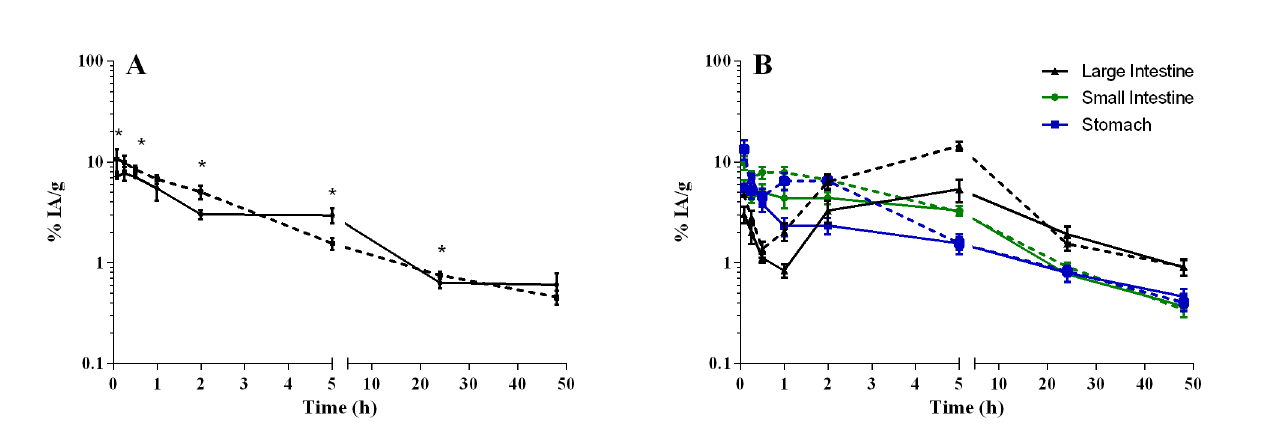
Figure 3 Antimony elimination pathways in uninfected [22] and L. ( L. ) amazonensis -infected BALB/c mice after intraperitoneal administration of meglumine antimoniate. A : kidney; B : gastrointestinal tract. Continuous line: infected mice; dotted line: uninfected mice. Data are shown as the mean ± standard deviation (n= 5/time) of the percentage of injected activity (IA) per gram. The significance of differences between uninfected and infected mice was calculated by Student’s t test. * p < 0.05.